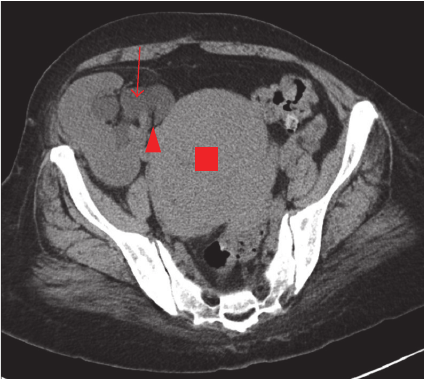
Figure 2: Contrasted T2-weighted magnetic resonance imaging. Rightpsoasabscesswasinconjunctionwiththetransplantedkidney. Ring-enhancement lesion was exhibited on magnetic resonance imaging (red arrow).